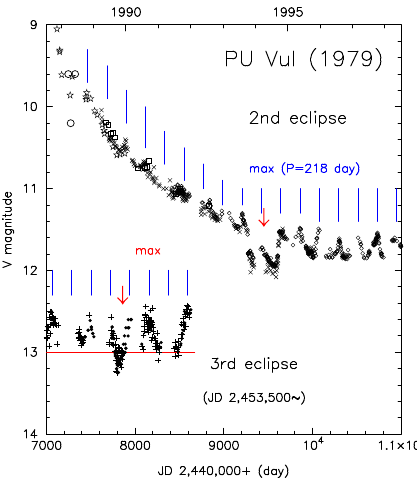
Fig. 6. A close-up view of the light curve of PU Vul for the period from JD 2 447 000 to 2 451 000 (upper curve) and from JD 2 453 500 to 2 457 500 (lower curve). The horizontal line indicates the magnitude m V = 13 : 0. Downward arrows indicate the central time of the eclipses, JD 2 449 447 and 2 454 362. Short vertical lines indicate epochs of the maximum magnitudes of pulsation of the M giant with a period of 218